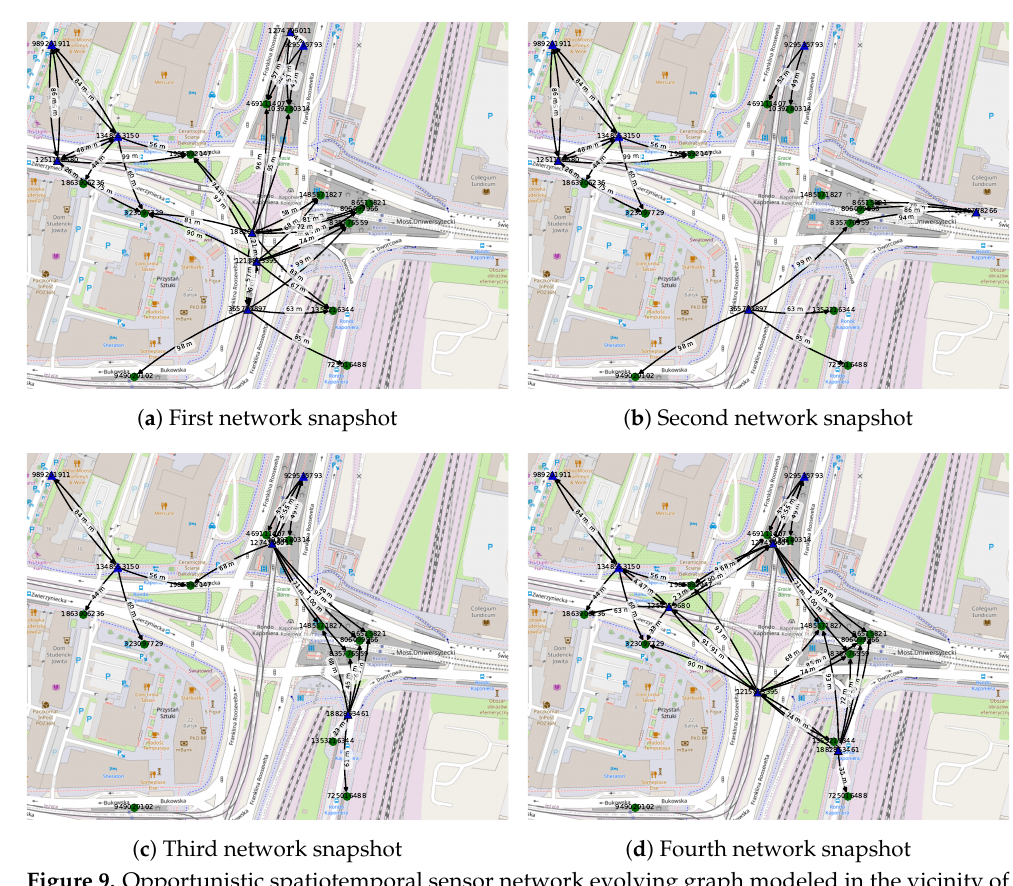
Figure 9. Opportunistic spatiotemporal sensor network evolving graph modeled in the vicinity of Kaponiera Roundabout in Pozna´n on 27 November